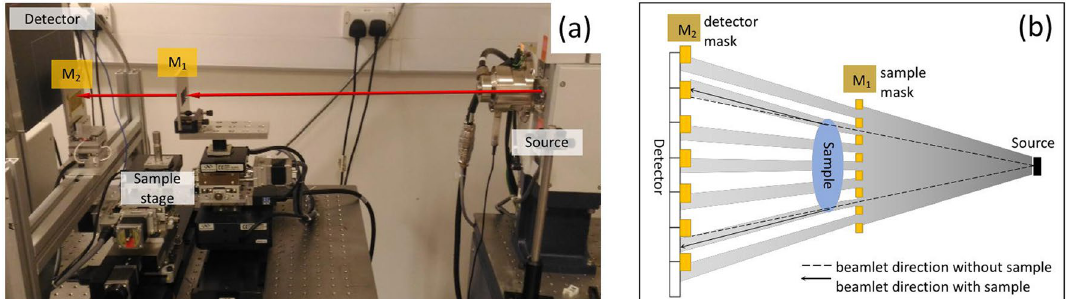
Figure 5. The breadboard XPCI-CT system. ( a ) A photograph of the system, with flat panel detector, the two masks in aluminium frames and the X-ray source (on a separate table) recognisable from left to right. ( b ) A schematic of the system (seen from above, not to scale), showing how mask M1 splits the beam into multiple beamlets before the sample, and how these hit the edges of an aperture on the detector mask M2. The way in which small deviations of the beamlets lead to a change of detected intensity in some pixels is also